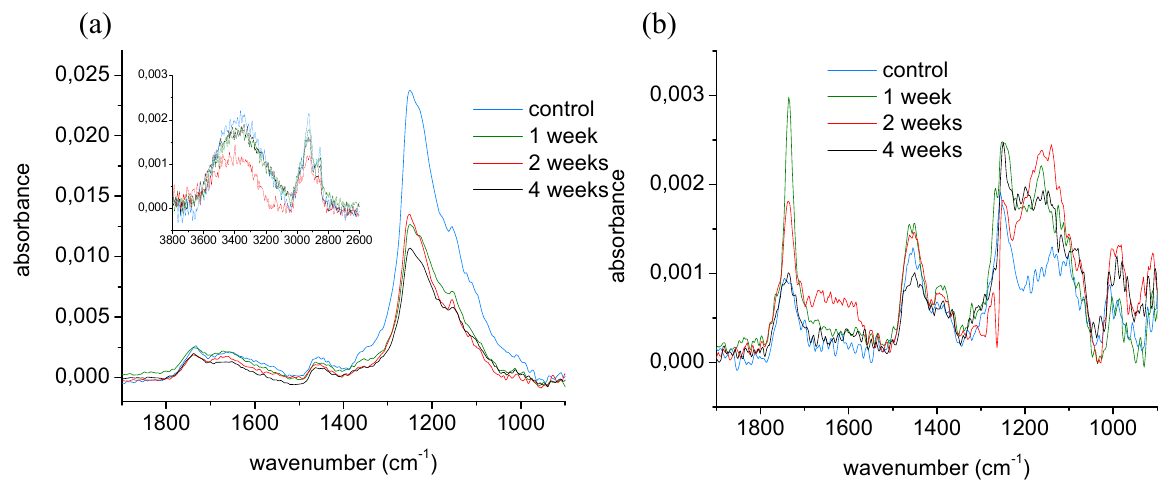
Figure 5. FT-IR spectra (ATR mode) of (a) flat samples and (b) deformed samples at different periods of